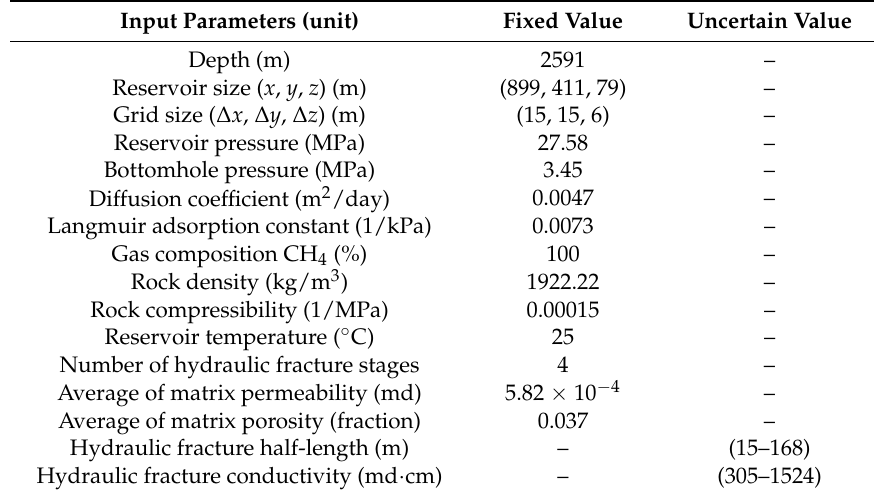
Table 2. Natural fracture properties of the synthetic reservoir.